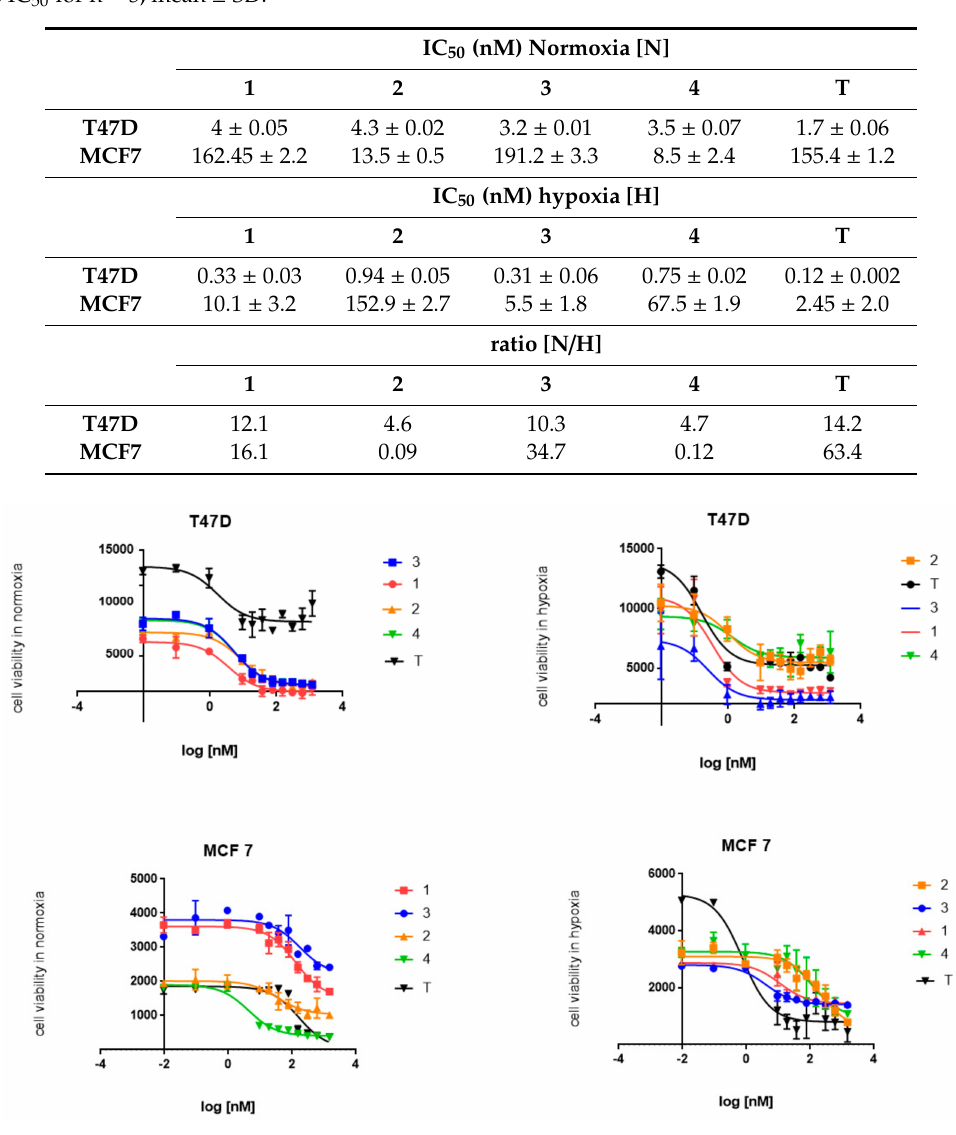
Figure 2. WST cytotoxicity assay; tested breast cancer lines (T47D and MCF7) were exposed to compounds 1–4 and tirapazamine (T); n = 3, data presented as mean ±